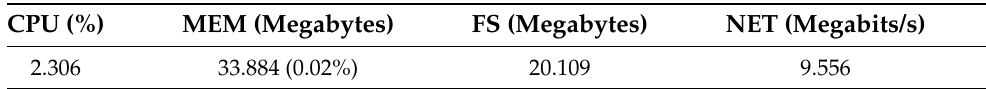
Table 2. Average values of resource